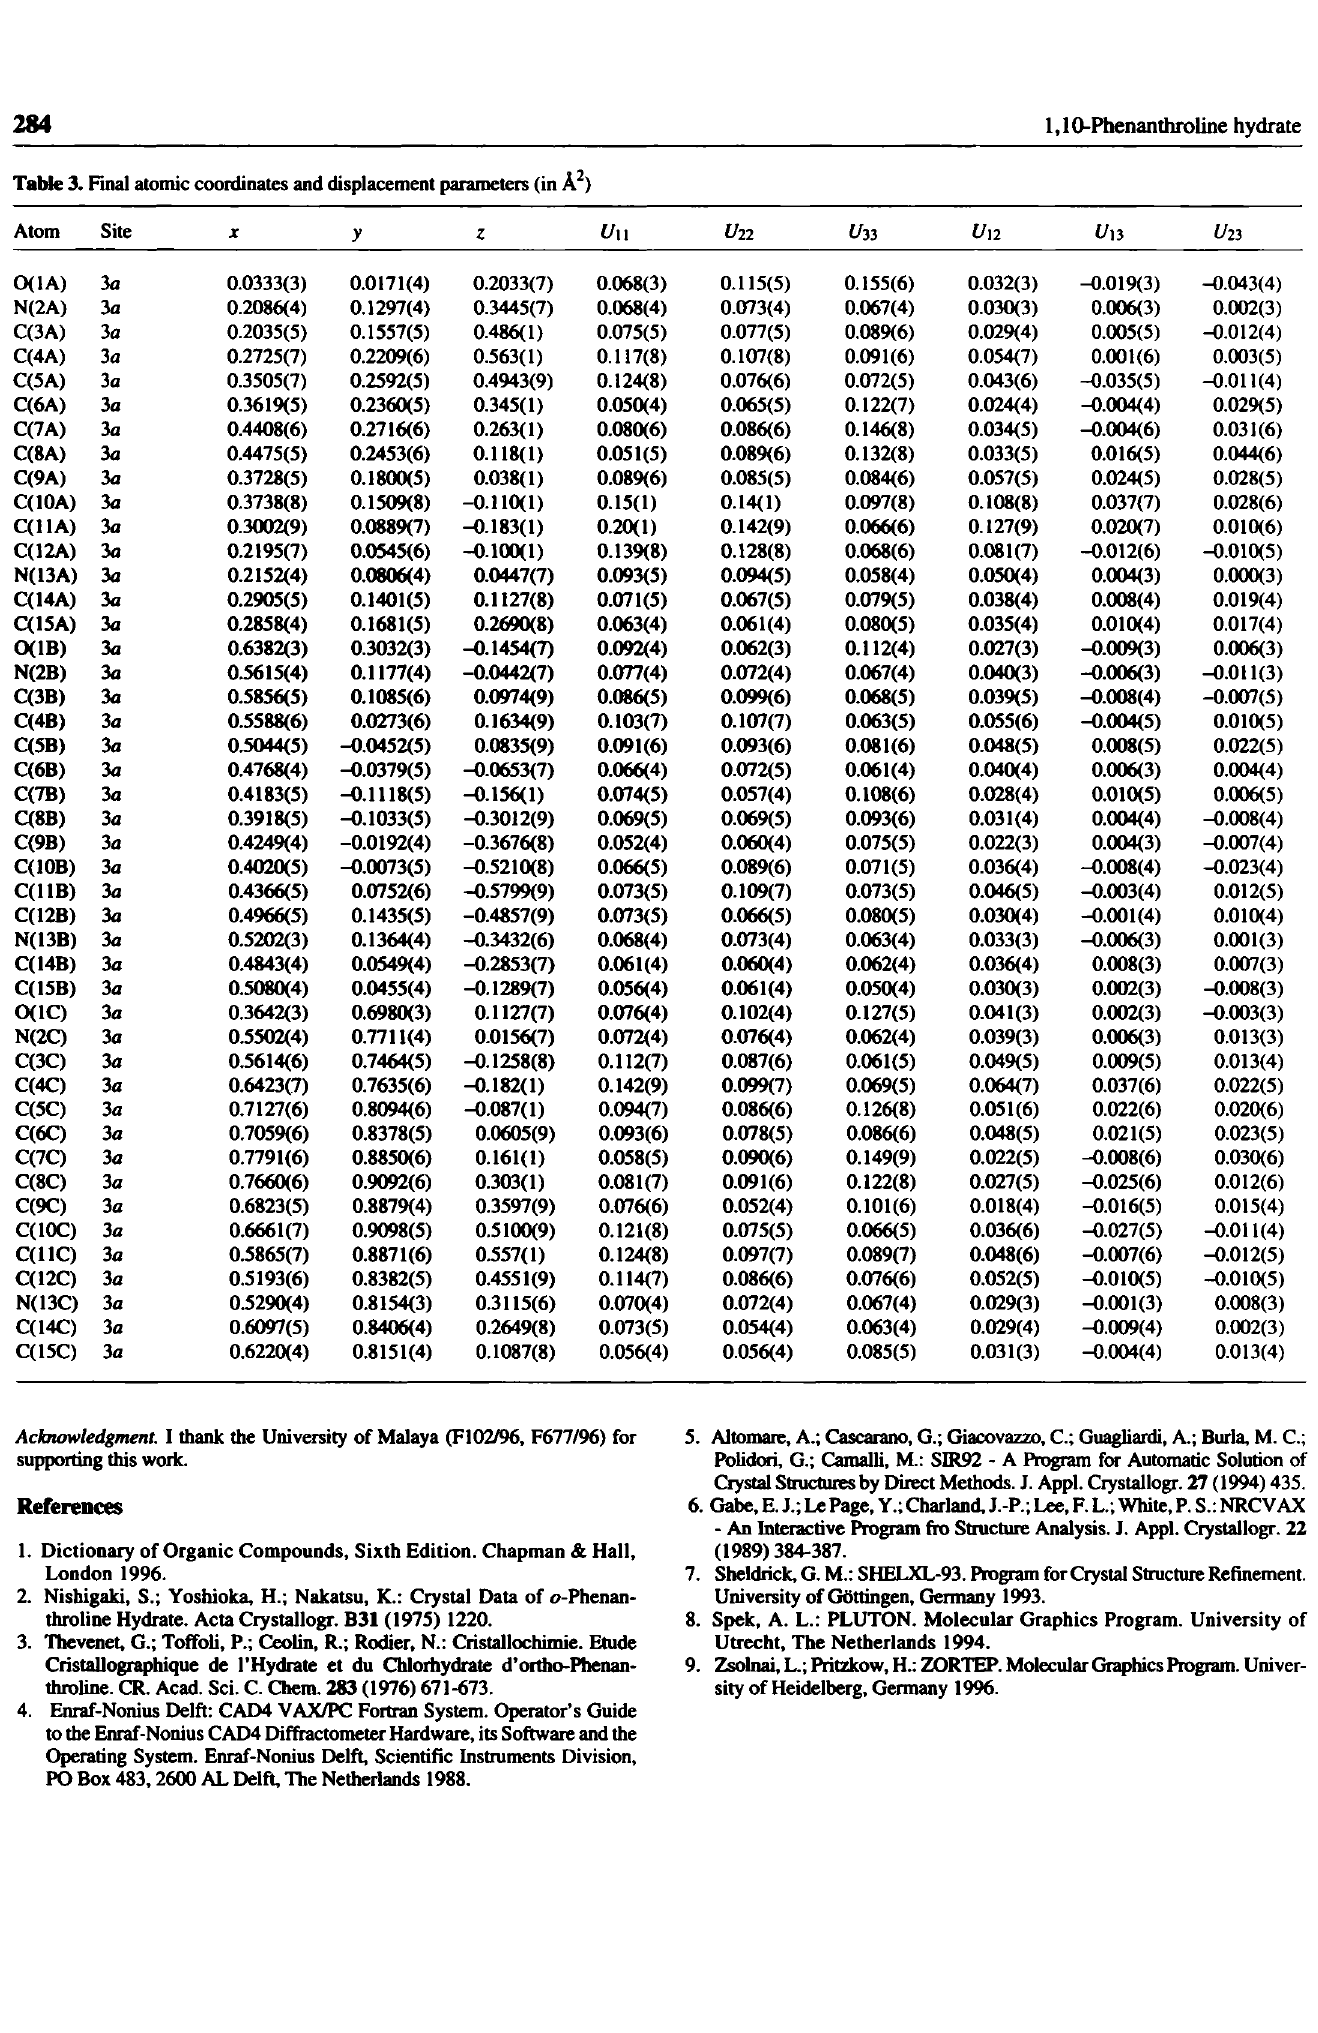
Table 3. Final atomic coordinates and displacement parameters (in Â 2